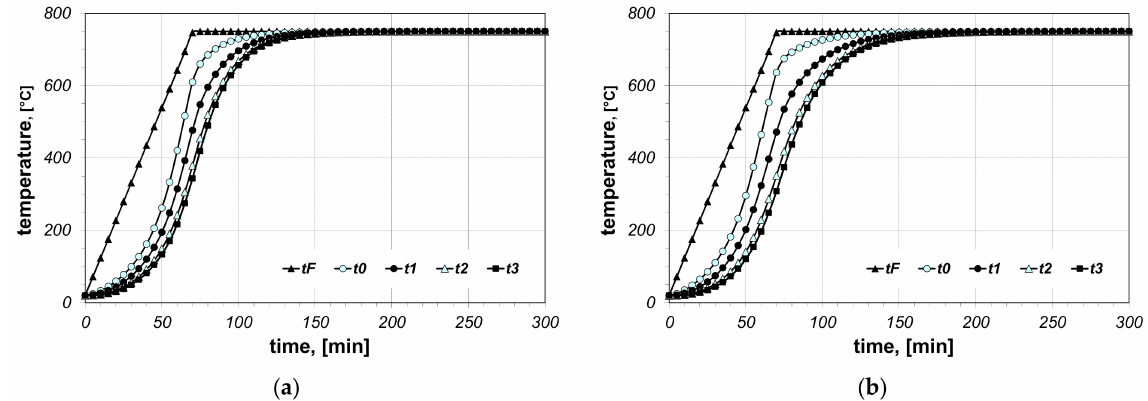
Figure 10. Calculated values of temperatures for heating of a 10 × 40 bar bundle with mixed arrangement: ( a ) results obtained for R ct-min , ( b ) results obtained for R ct-max .